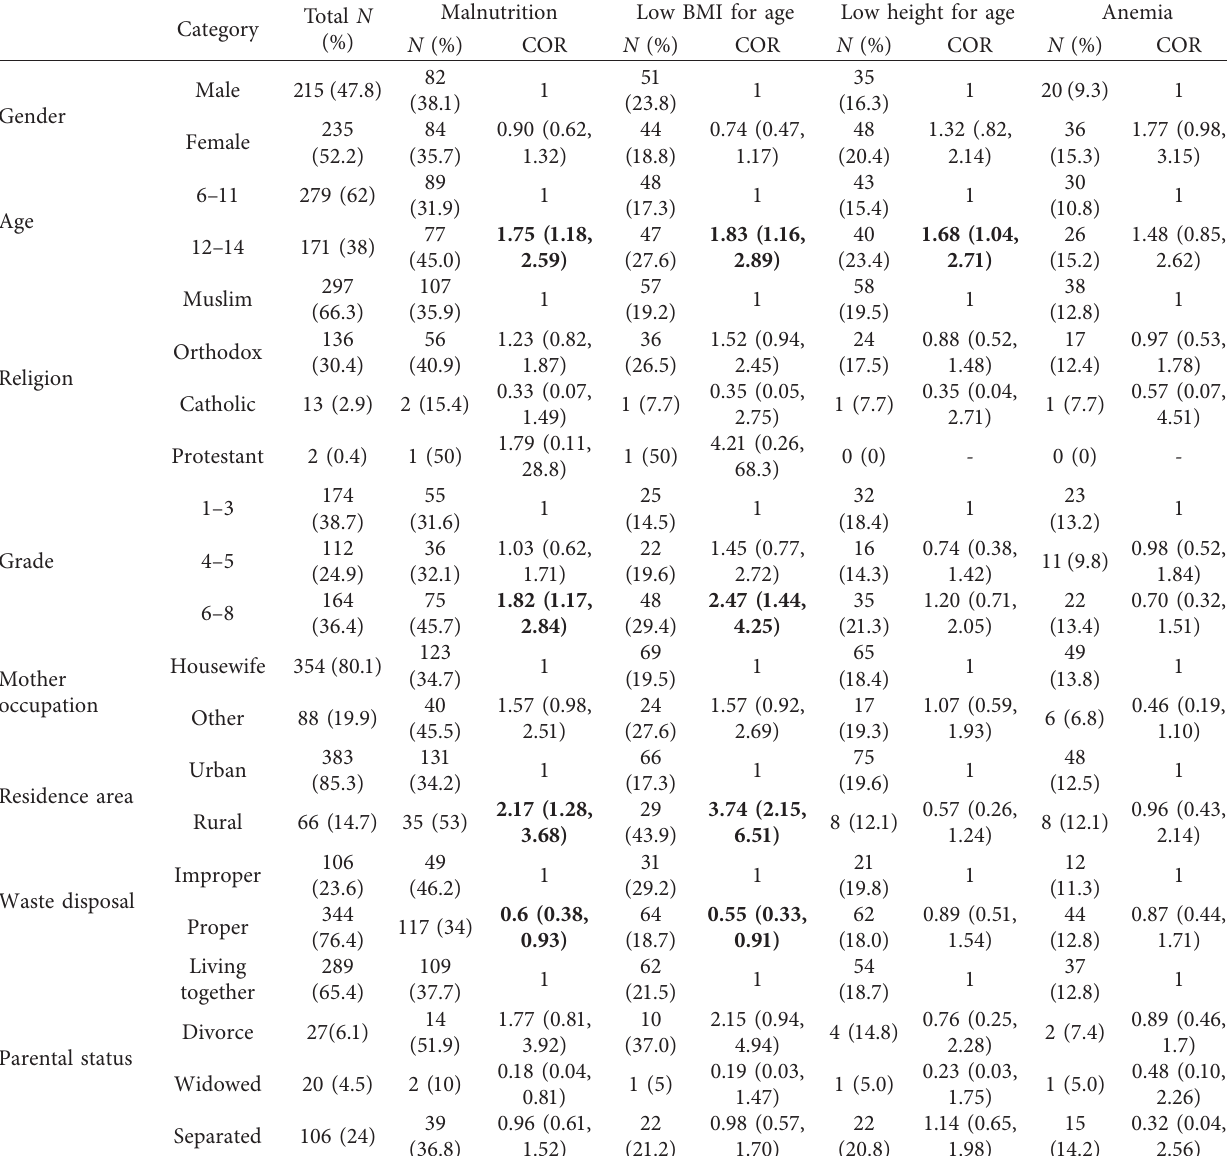
Table 4: Potential risk factors associated with malnutrition, stunting, wasting, and anemia in Ghindae area, Eritrea, 2018 ( n � 450). Total N Malnutrition Category Gender